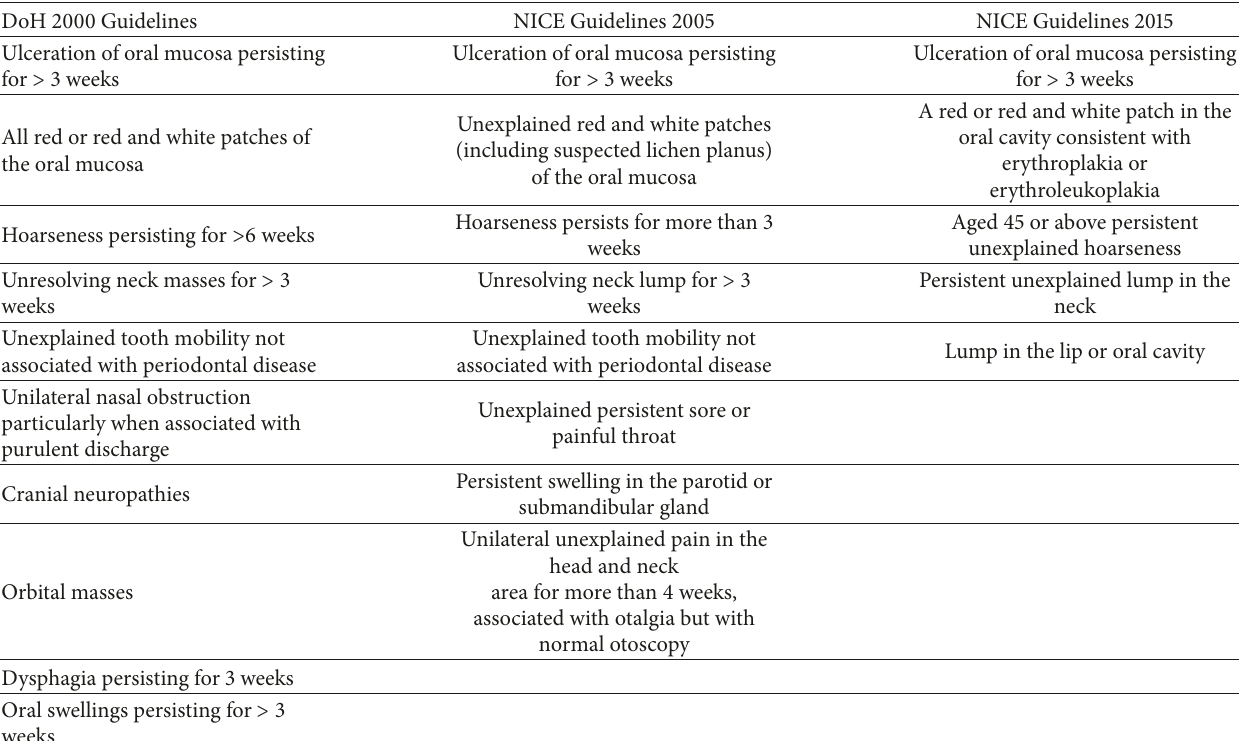
Table 1: Symptoms suspecting cancer for urgent referral.